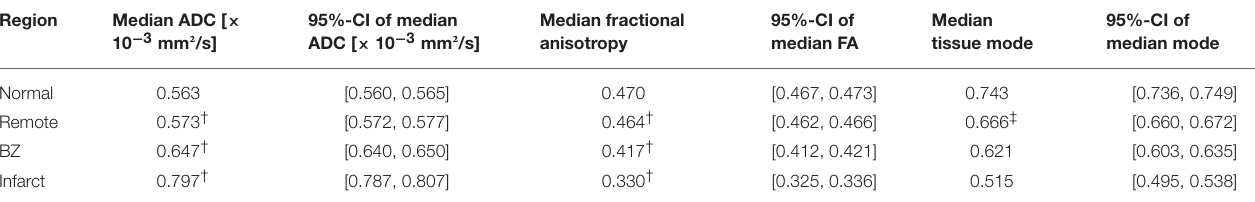
TABLE 1 | Pooled tensor invariant medians and bootstrapped 95%-CIs of the medians for normal, remote, border zone (BZ), and infarcted myocardium.